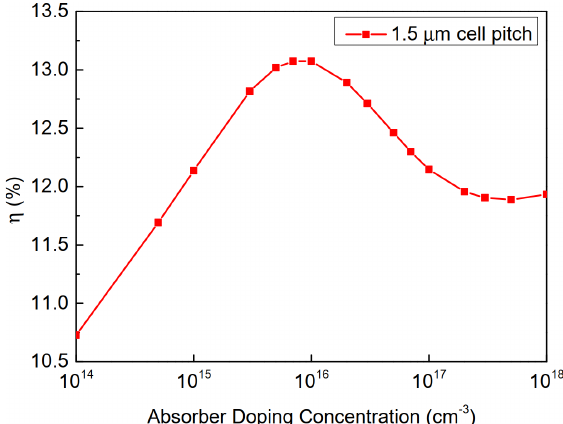
Figure 11. Effect of doping density in u-CIGS absorber on built-in electric field and total recombi- nation rates at the CdS/u-CIGS and u-CIGS/Al 2 O 3 interfaces under illumination—0 V Bias.